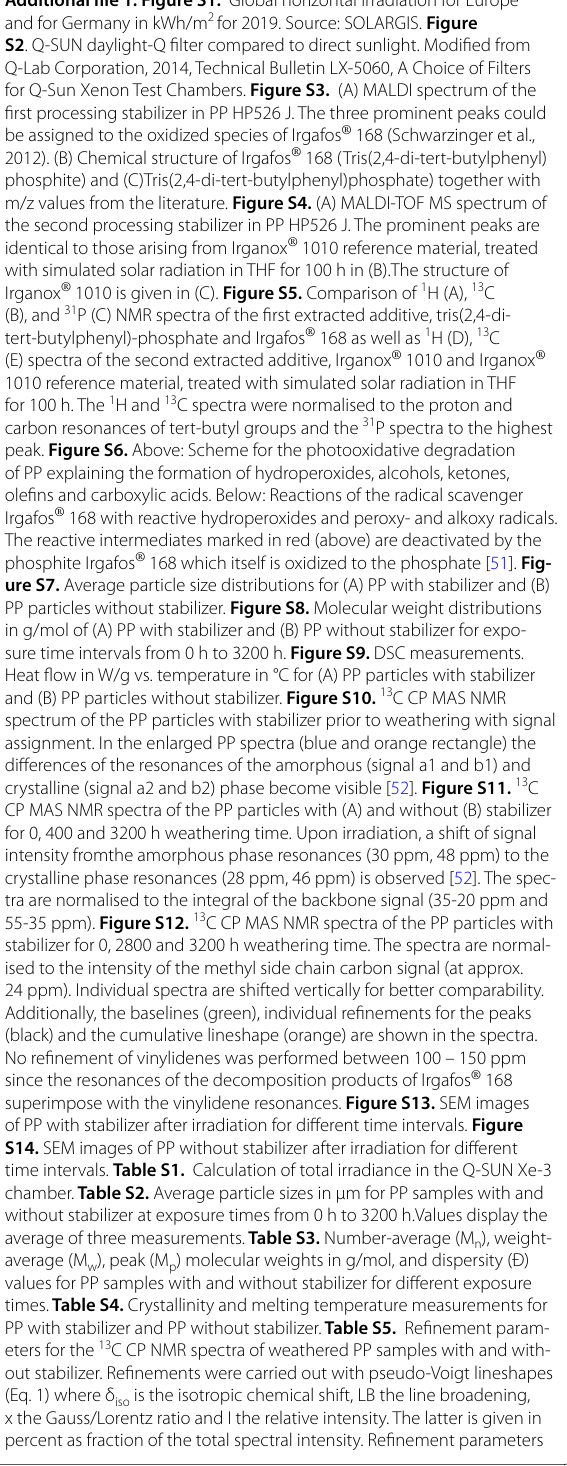
peak. Figure S6. Above: Scheme for the photooxidative degradation of PP explaining the formation of hydroperoxides, alcohols, ketones, olefins and carboxylic acids. Below: Reactions of the radical scavenger Irgafos ® 168 with reactive hydroperoxides and peroxy- and alkoxy radicals. The reactive intermediates marked in red (above) are deactivated by the phosphite Irgafos ® 168 which itself is oxidized to the phosphate [51]. Fig‑ ure S7. Average particle size distributions for (A) PP with stabilizer and (B) PP particles without stabilizer. Figure S8. Molecular weight distributions in g/mol of (A) PP with stabilizer and (B) PP without stabilizer for expo- sure time intervals from 0 h to 3200 h. Figure S9. DSC measurements. Heat flow in W/g vs. temperature in °C for (A) PP particles with stabilizer and (B) PP particles without stabilizer. Figure S10. 13 C CP MAS NMR spectrum of the PP particles with stabilizer prior to weathering with signal assignment. In the enlarged PP spectra (blue and orange rectangle) the differences of the resonances of the amorphous (signal a1 and b1) and crystalline (signal a2 and b2) phase become visible [52]. Figure S11. 13 C CP MAS NMR spectra of the PP particles with (A) and without (B) stabilizer for 0, 400 and 3200 h weathering time. Upon irradiation, a shift of signal intensity fromthe amorphous phase resonances (30 ppm, 48 ppm) to the crystalline phase resonances (28 ppm, 46 ppm) is observed [52]. The spec- tra are normalised to the integral of the backbone signal (35-20 ppm and 55-35 ppm). Figure S12. 13 C CP MAS NMR spectra of the PP particles with stabilizer for 0, 2800 and 3200 h weathering time. The spectra are normal- ised to the intensity of the methyl side chain carbon signal (at approx. 24 ppm). Individual spectra are shifted vertically for better comparability. Additionally, the baselines (green), individual refinements for the peaks (black) and the cumulative lineshape (orange) are shown in the spectra. No refinement of vinylidenes was performed between 100 – 150 ppm since the resonances of the decomposition products of Irgafos ® 168 superimpose with the vinylidene resonances. Figure S13. SEM images of PP with stabilizer after irradiation for different time intervals. Figure S14. SEM images of PP without stabilizer after irradiation for different time intervals. Table S1. Calculation of total irradiance in the Q-SUN Xe-3 chamber. Table S2. Average particle sizes in µm for PP samples with and without stabilizer at exposure times from 0 h to 3200 h.Values display the average of three measurements. Table S3. Number-average (M n ), weight- average (M w ), peak (M p ) molecular weights in g/mol, and dispersity (Ð) values for PP samples with and without stabilizer for different exposure times. Table S4. Crystallinity and melting temperature measurements for PP with stabilizer and PP without stabilizer. Table S5. Refinement param- eters for the 13 C CP NMR spectra of weathered PP samples with and with- out stabilizer. Refinements were carried out with pseudo-Voigt lineshapes (Eq. 1) where δ iso is the isotropic chemical shift, LB the line broadening, x the Gauss/Lorentz ratio and I the relative intensity. The latter is given in percent as fraction of the total spectral intensity. Refinement